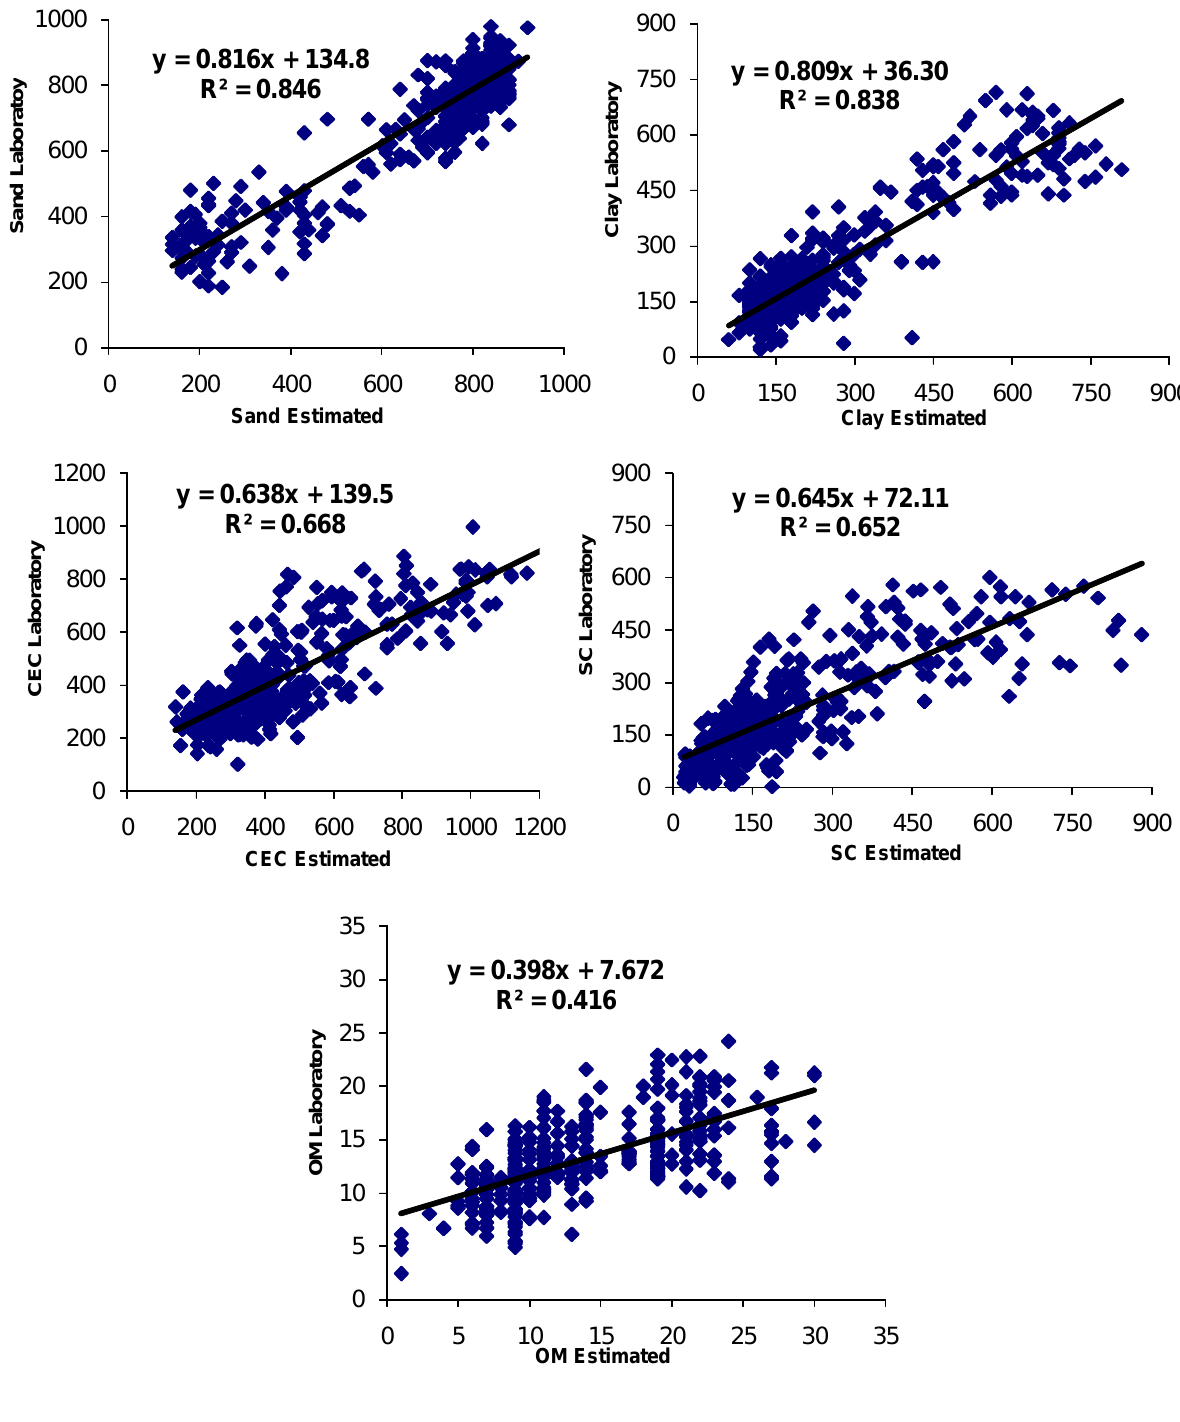
Figure 2. Scatter plot of laboratory determined soil values obtained by routine analysis (Determined Value (Y)) and estimated values obtained with the spectral regression models (Estimated Value